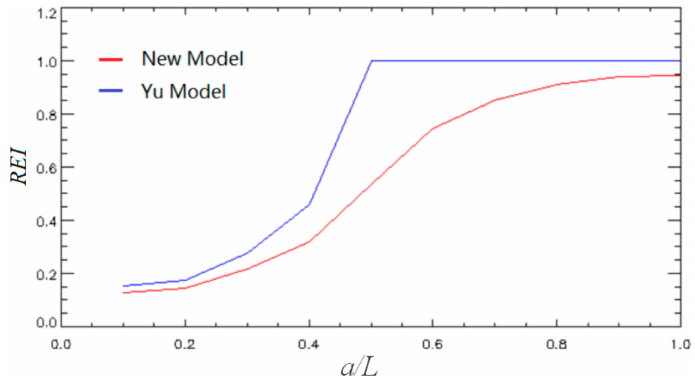
Figure 7. Row e ff ect index ( REI ) changes with row structure